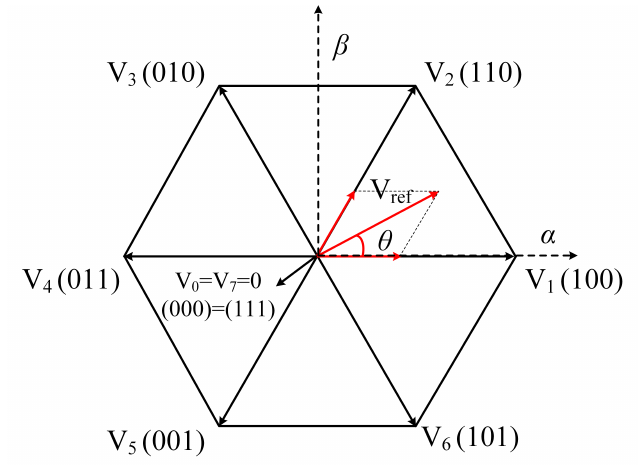
Figure 5. Eight possible input voltage